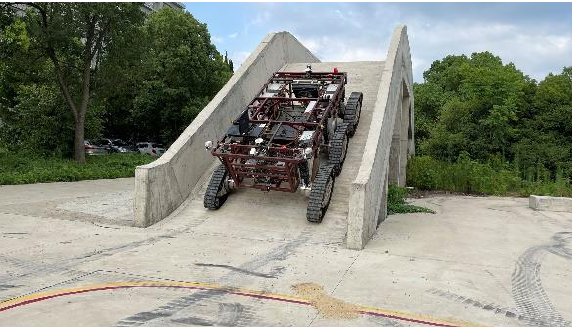
Figure 16. Snapshot of the autonomous controller traversing the slope terrain.